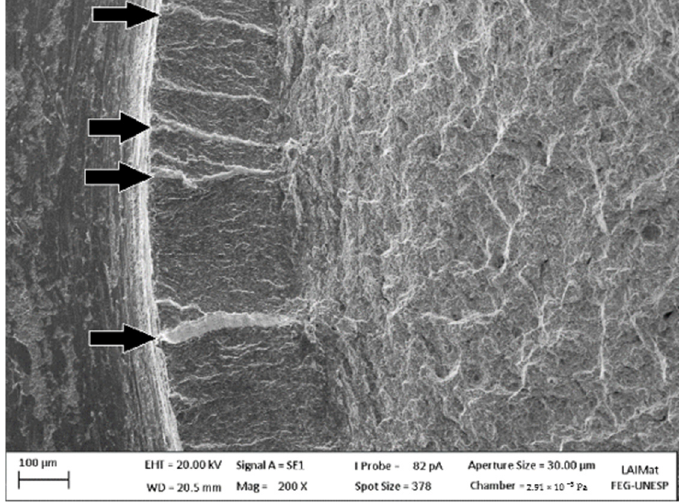
Figure 22. Fractography of a threaded specimen tested at a maximum stress of 793 MPa (9.12 × 10 3 cycles).